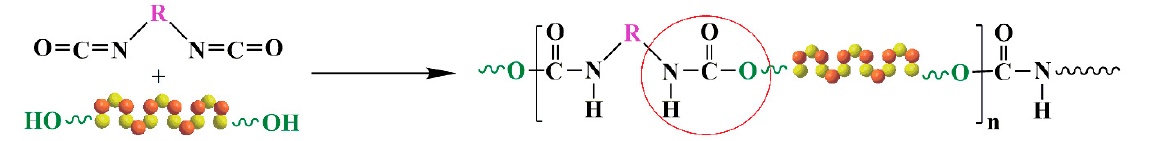
Figure 1. Gelling reaction between the isocyanate and polyols.